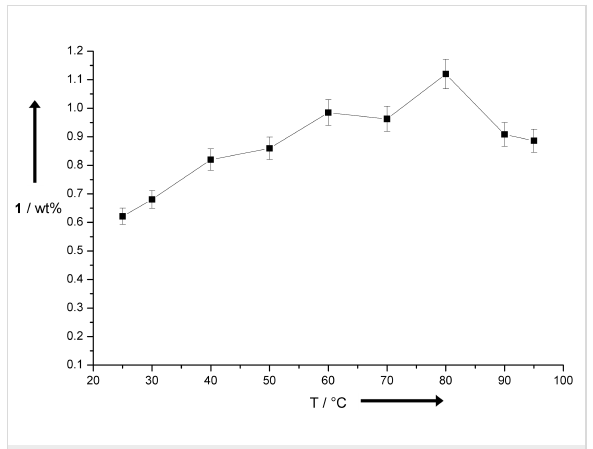
Figure 4: Influence of the reaction temperature onto anodic degrad- ation of lignin using stainless steel electrodes.